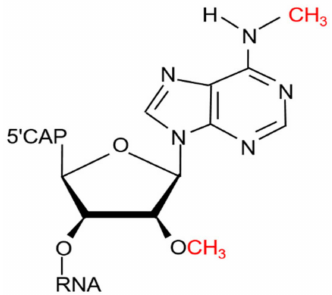
Figure 1. Chemical structures of m 6 Am